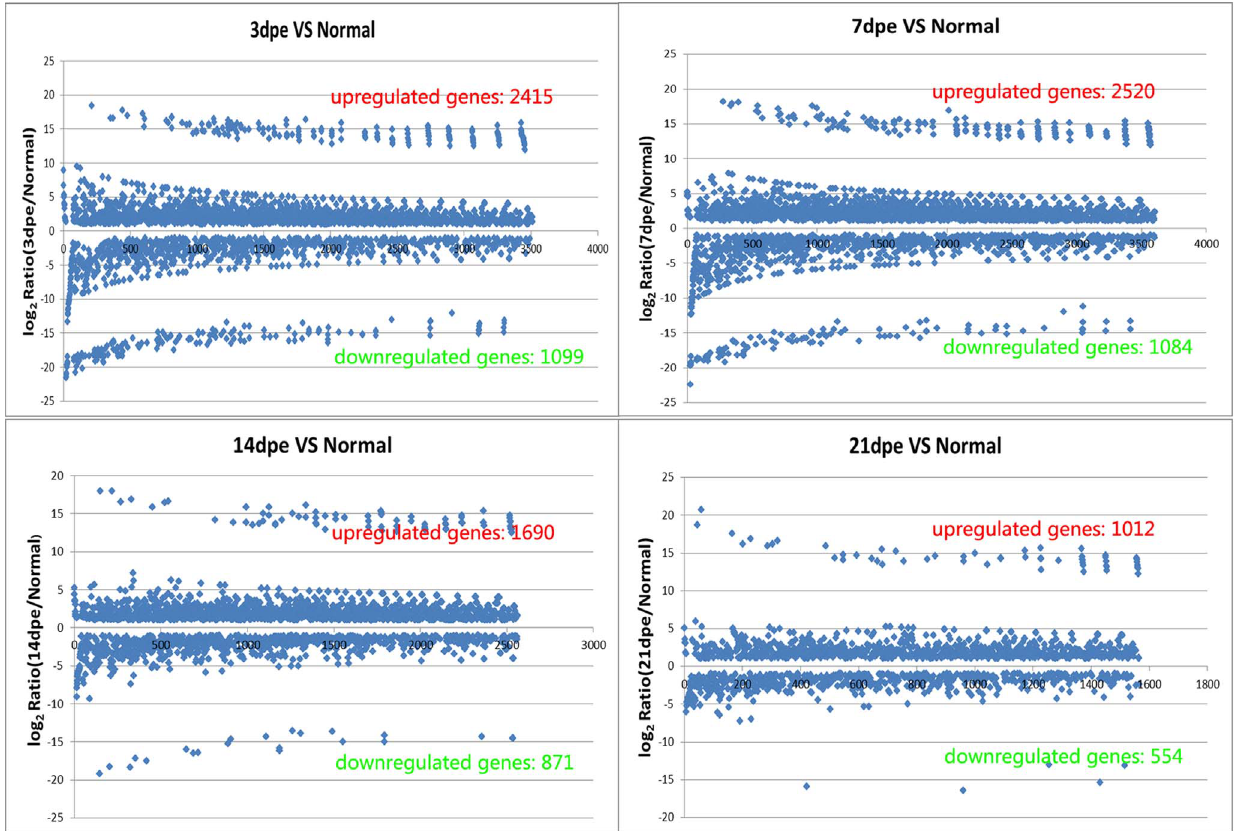
Figure 1. The change level of global differential expression genes during intestine regeneration in sea cucumber A.japonicus . The principle "FDR # 0.001 and the absolute value of log2Ratio $ 1’’ was used as a threshold to screen DEGs. The figure showed that not only a large number of genes were differentially expressed, but the change fold of differentially expression was at a high level, especially at the early stage of intestine regeneration.